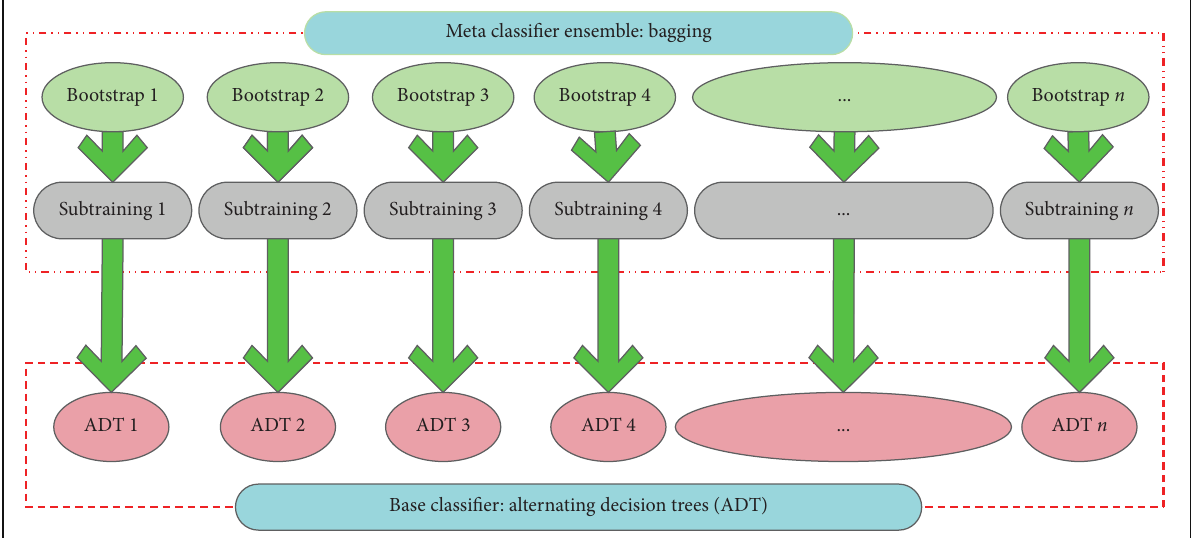
Figure 9: Novel technique ensemble framework used in this study.